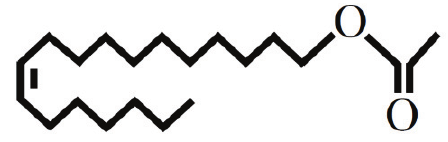
Figure 5. Molecular structure of cis -vaccenyl